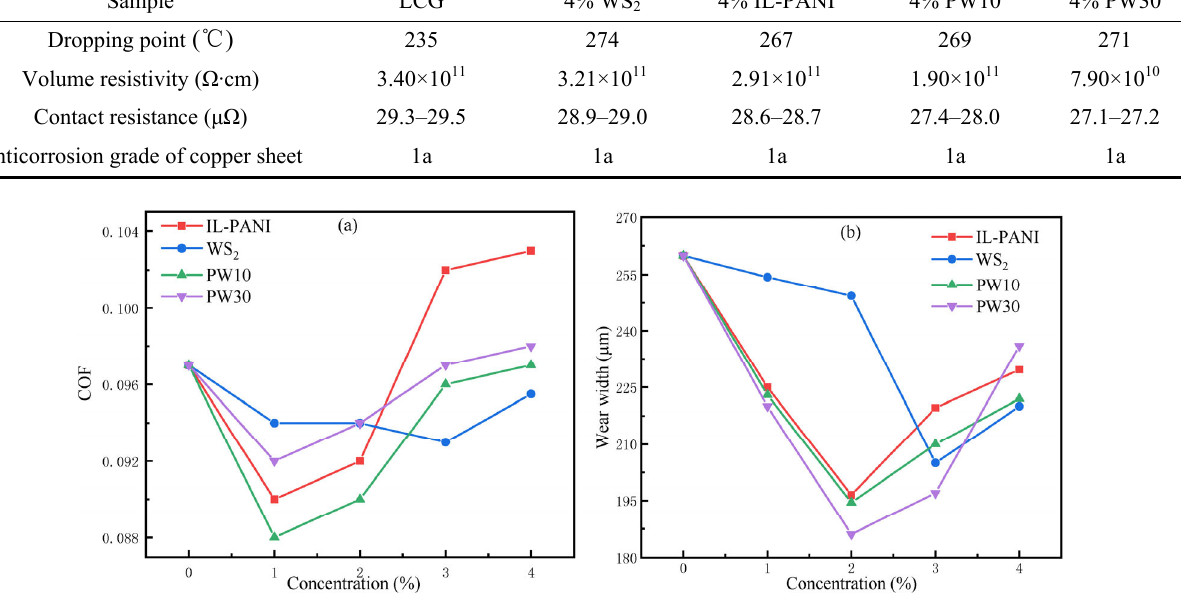
Fig. 4 (a) COFs and (b) wear widths of various greases with different additive concentrations (voltage: 0 V; load: 50 N; frequency: 5 Hz; stroke: 5